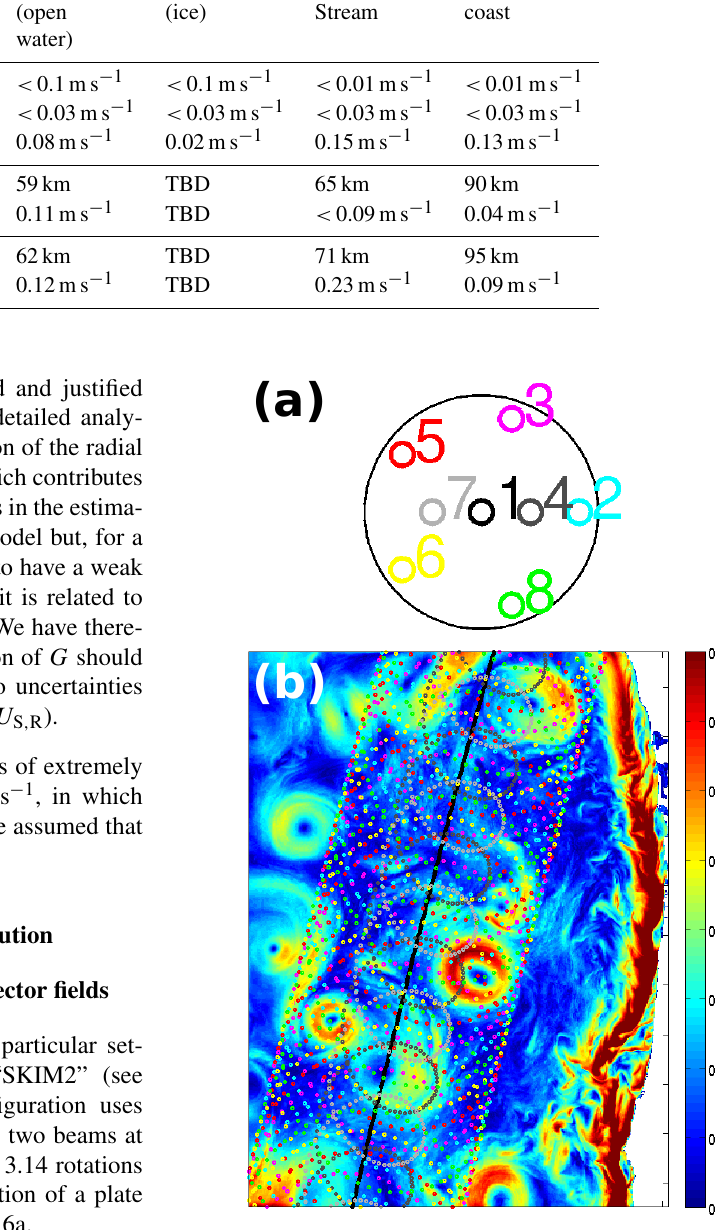
Figure 6. (a) Pattern of beams (1 is at nadir, 4 and 7 are at 6 ◦ , the others at 12 ◦ incidence). The different colors help associating the footprint patterns in (b) with each beam. Background colors in (b) represent simulated current velocities off the Oregon coast (in ms − 1 ), courtesy of Y. Chao, previously used by Fu and Ubel- mann (2014) for the evaluation of the SWOT mission